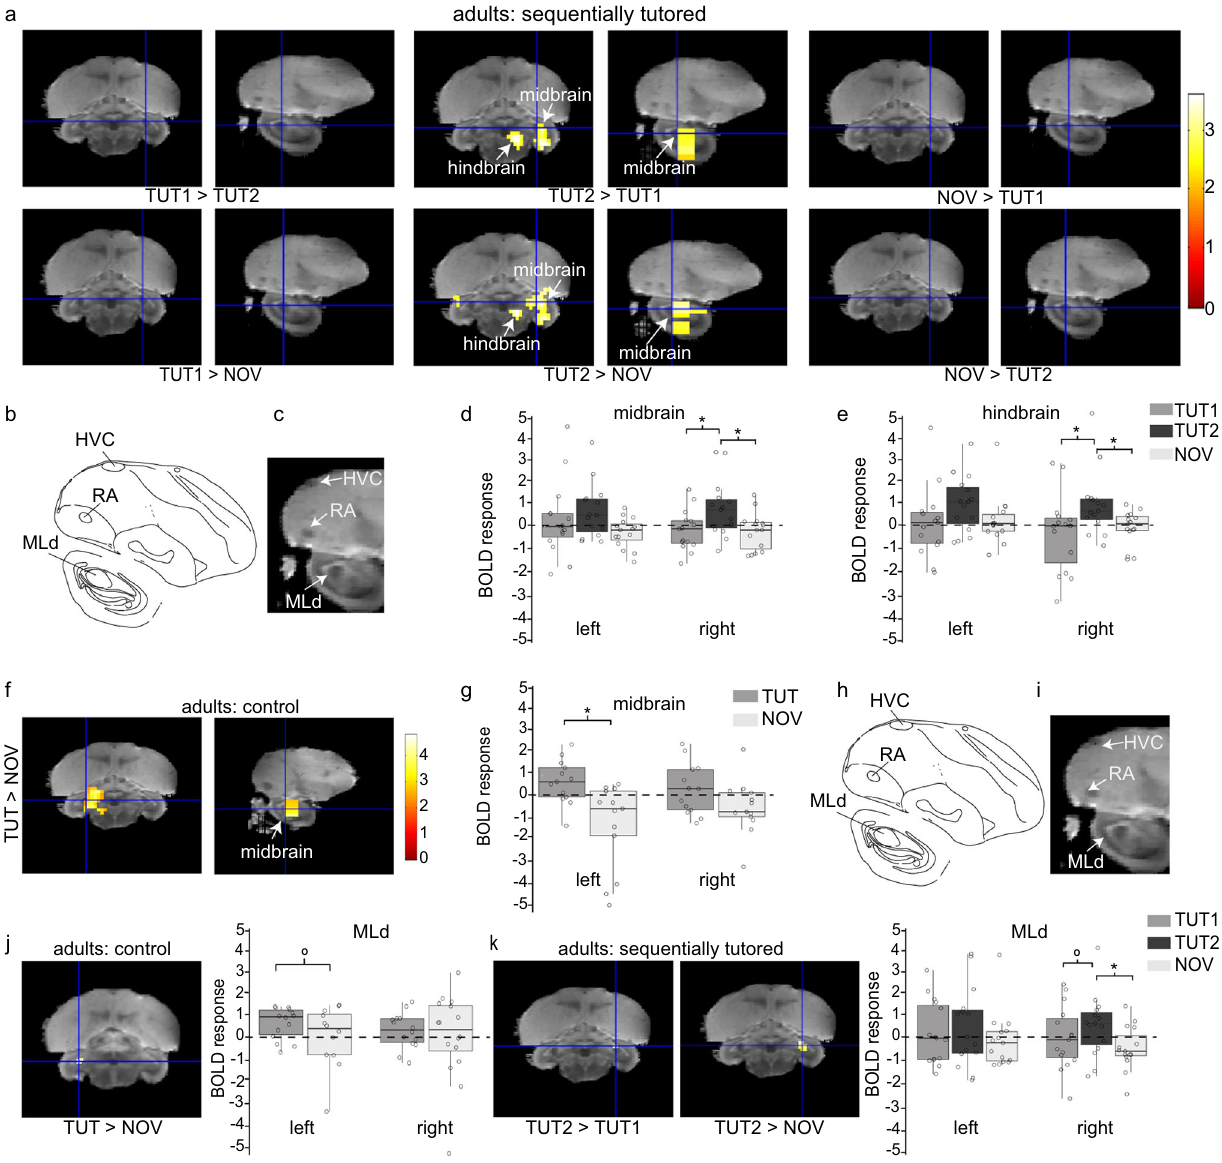
Fig. 3 Brain regions activated by song in 90-day-old birds. a Statistical maps of all post hoc t tests performed within the main effect of stimulus in sequentially tutored birds. Blue cross-hairs indicate the location of MLd in the zebra fi nch MRI atlas. b , c Detailed view of the exact location of the activated cluster observed within the midbrain. d , e BOLD response ( β weights) elicited by each stimulus relative to the rest periods in the clusters indicated with white arrows in ( b ). Boxplots showing the interquartile range (box), median (black line), and 1st and 3rd quartile; each individual bird is represented by a circle (* P uncorrected < 0.01, N = 15). f , g Statistical map of BOLD activation induced by tutor over novel conspeci fi c songs (paired t tests) in control birds and the corresponding BOLD response ( β weights) elicited by TUT and NOV song relative to rest periods. Boxplots showing the interquartile range (box), median (black line), and 1st and 3rd quartile; each individual bird is represented by a circle (* P uncorrected < 0.01, N = 13). All voxels with t > 2.46 ( P uncorrected < 0.01) are displayed. h , i Detailed view of the exact location of MLd. j , k Region-of- interest (ROI) analysis restricted to MLd shows that control birds ( j ) have a stronger differential BOLD response in left MLd while sequentially tutored birds ( k ) have a stronger differential BOLD response in right MLd. T values are color-coded according to the scale displayed on the right. P FWE < 0.05 considered as statistically signi fi cant for ROI analysis. MLd: dorsal lateral nucleus of the mesencephalon, RA: robust nucleus of the arcopallium. HVC is used as a proper